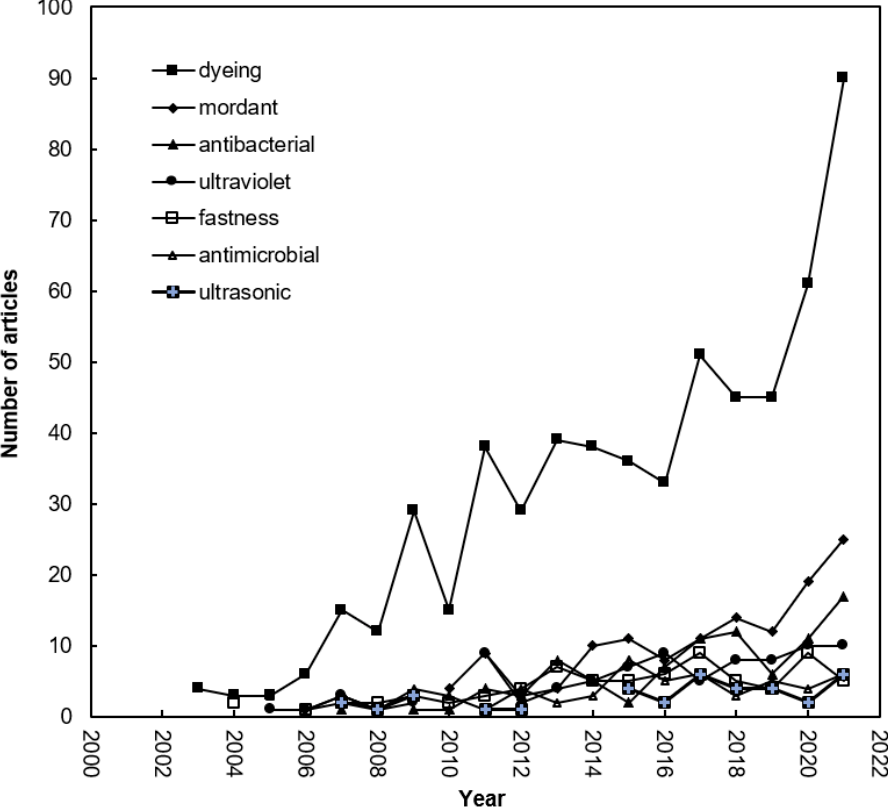
Figure 5. Development trends of the seven topics in textile coloration research with natural sources. Table 6. Top 20 words in titles, author keywords, and KeyWords Plus in publications related to textile coloration with natural sources.